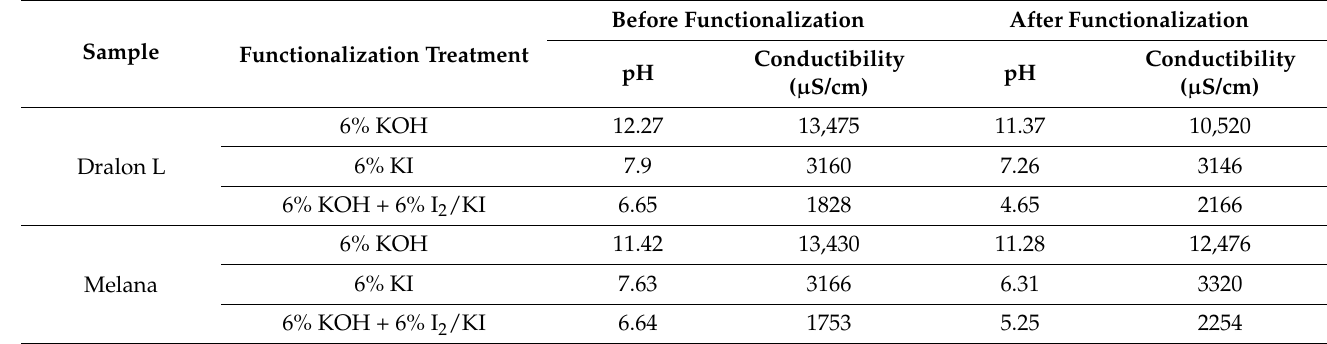
Table 2. pH and conductivity of treating liquors before and after functionalization.